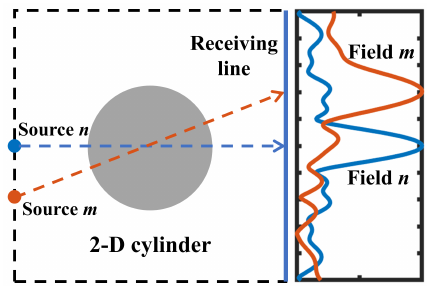
Figure 9. Diagram of the electric fields excited by two point sources at different positions, with a 2-D cylindrical scatterer in the